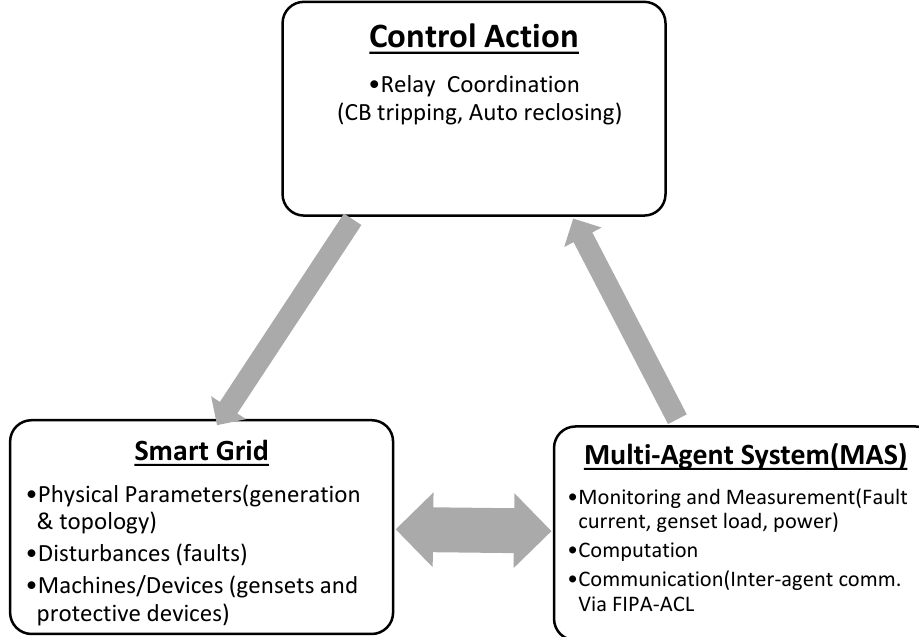
Figure 3. Generic design for SSG protection and security solution relying on MAS [35].